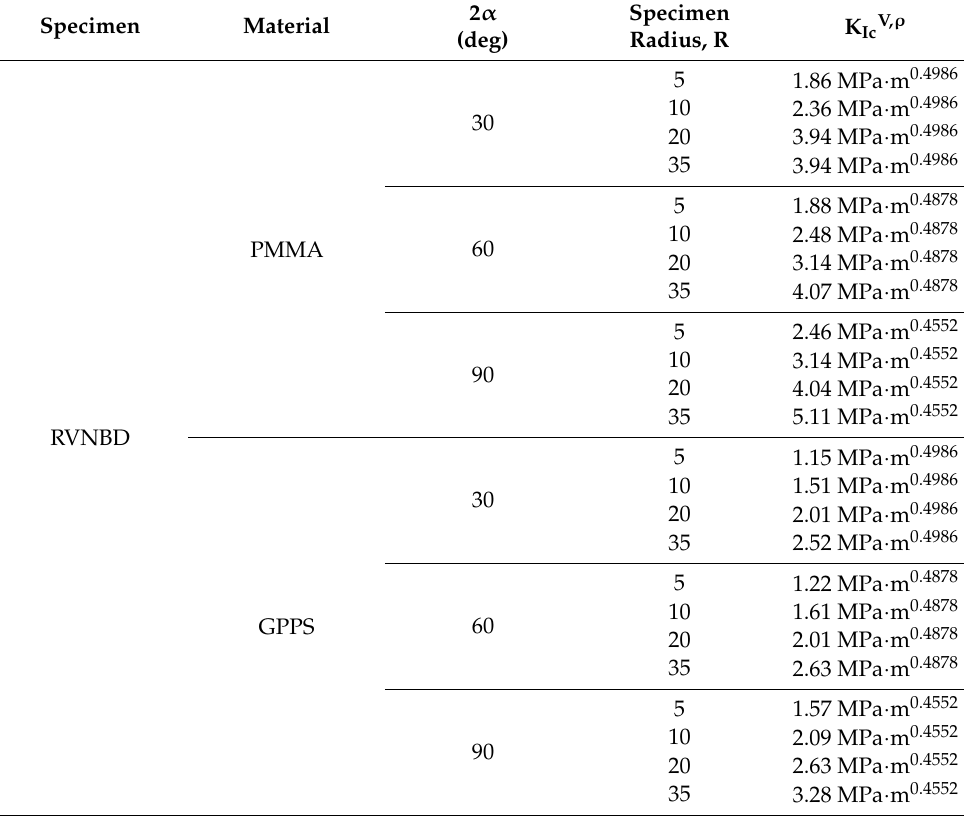
Table 5 gathers the values of the notch fracture toughness obtained for PMMA and GPPS in RVNBD and RVSCB specimens. As in the K Ic values, Table 5 reveals that K IcV, ρ depends on the size of the specimen and becomes larger as the size of the specimen grows. Table 5. K IcV, ρ values for PMMA and GPPS obtained from RVNBD and RVSCB specimens with different sizes (dimensions in mm, load values in